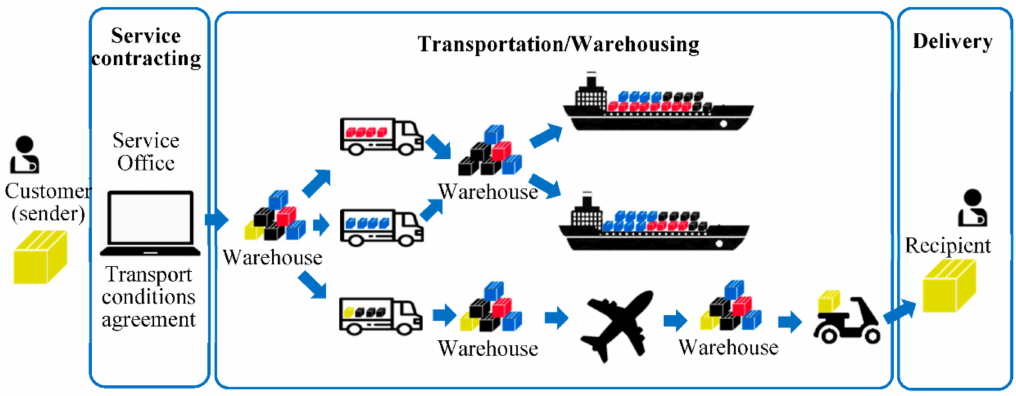
Figure 1. The transportation